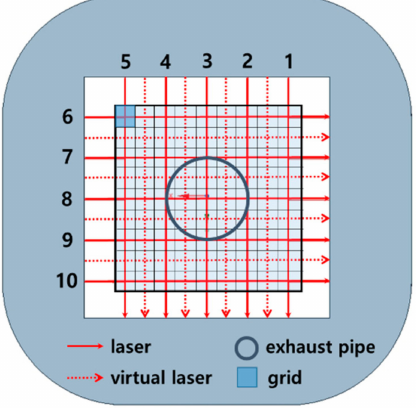
Figure 3. Laser paths and measurement